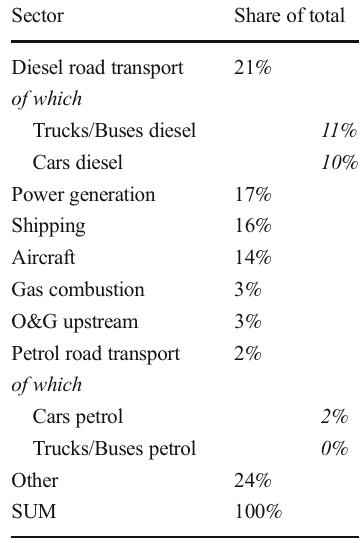
Table 1 NOx emissions by sector, UK,